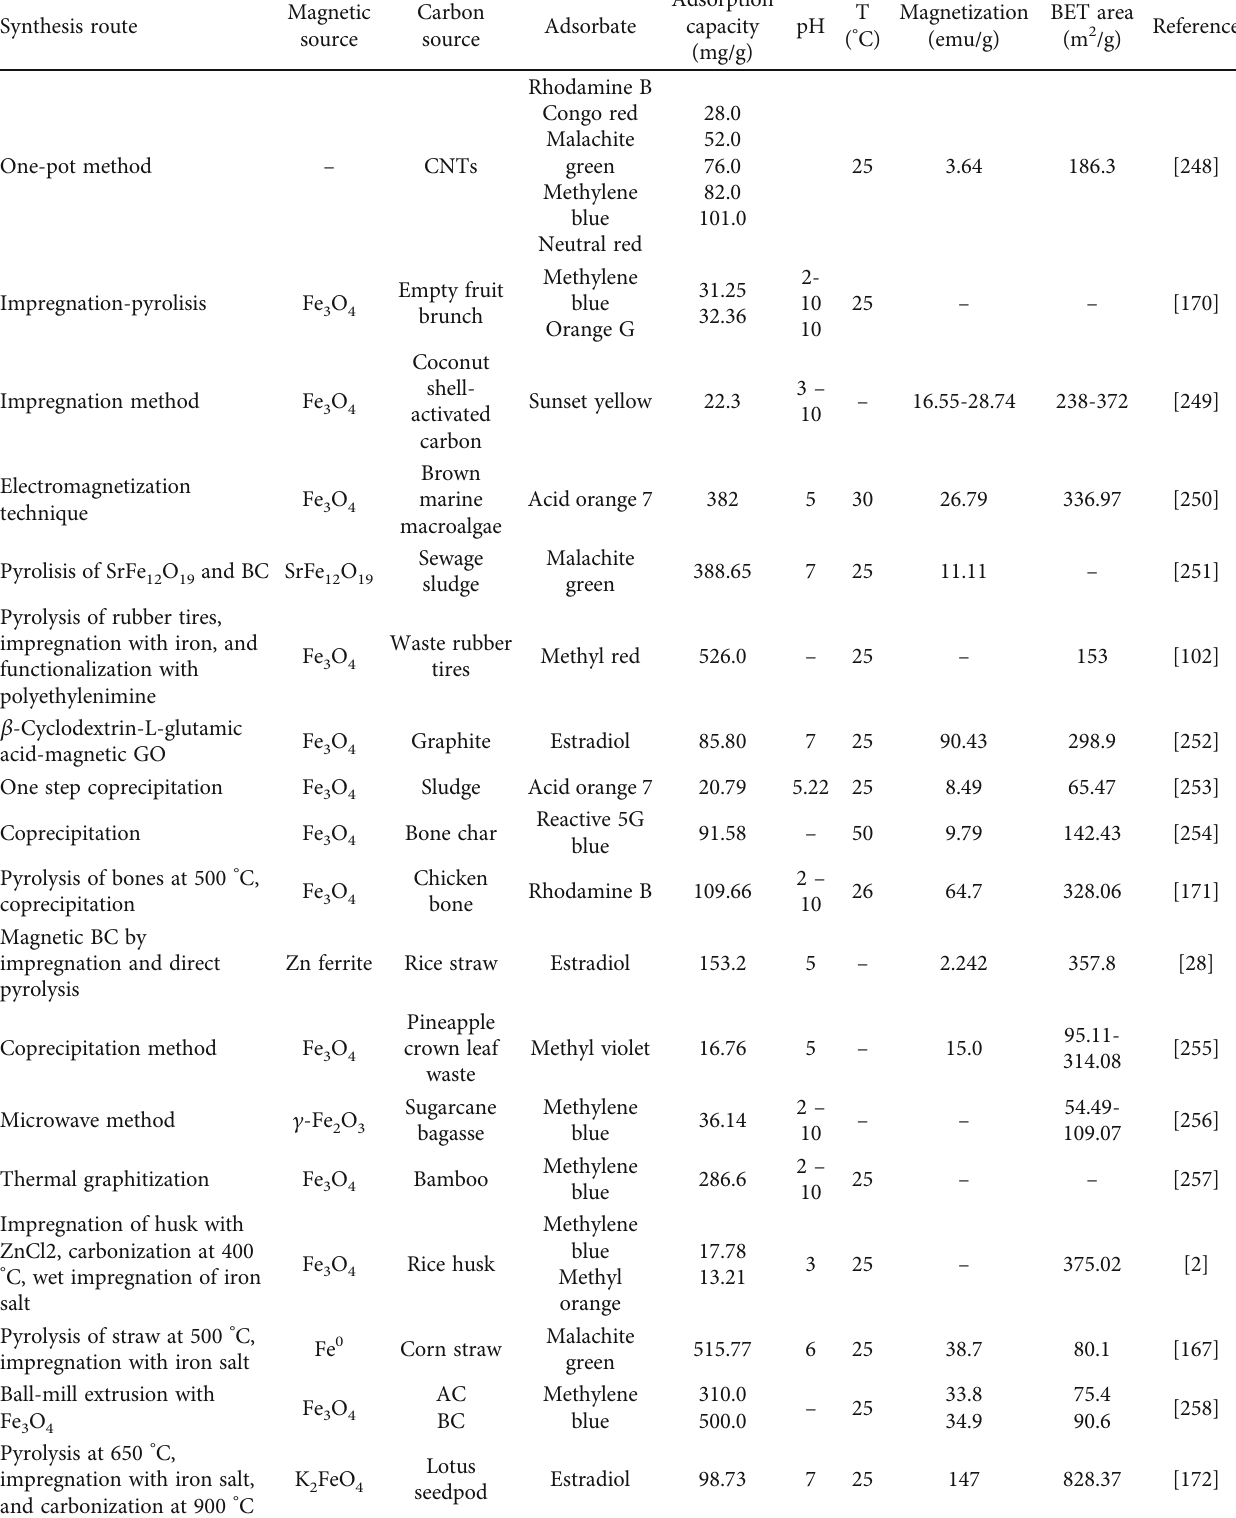
Table 6: Removal of dyes, organic pollutants and radionuclides from aqueous solution using magnetic carbon-based adsorbents: preparation, removal operating conditions, and adsorption